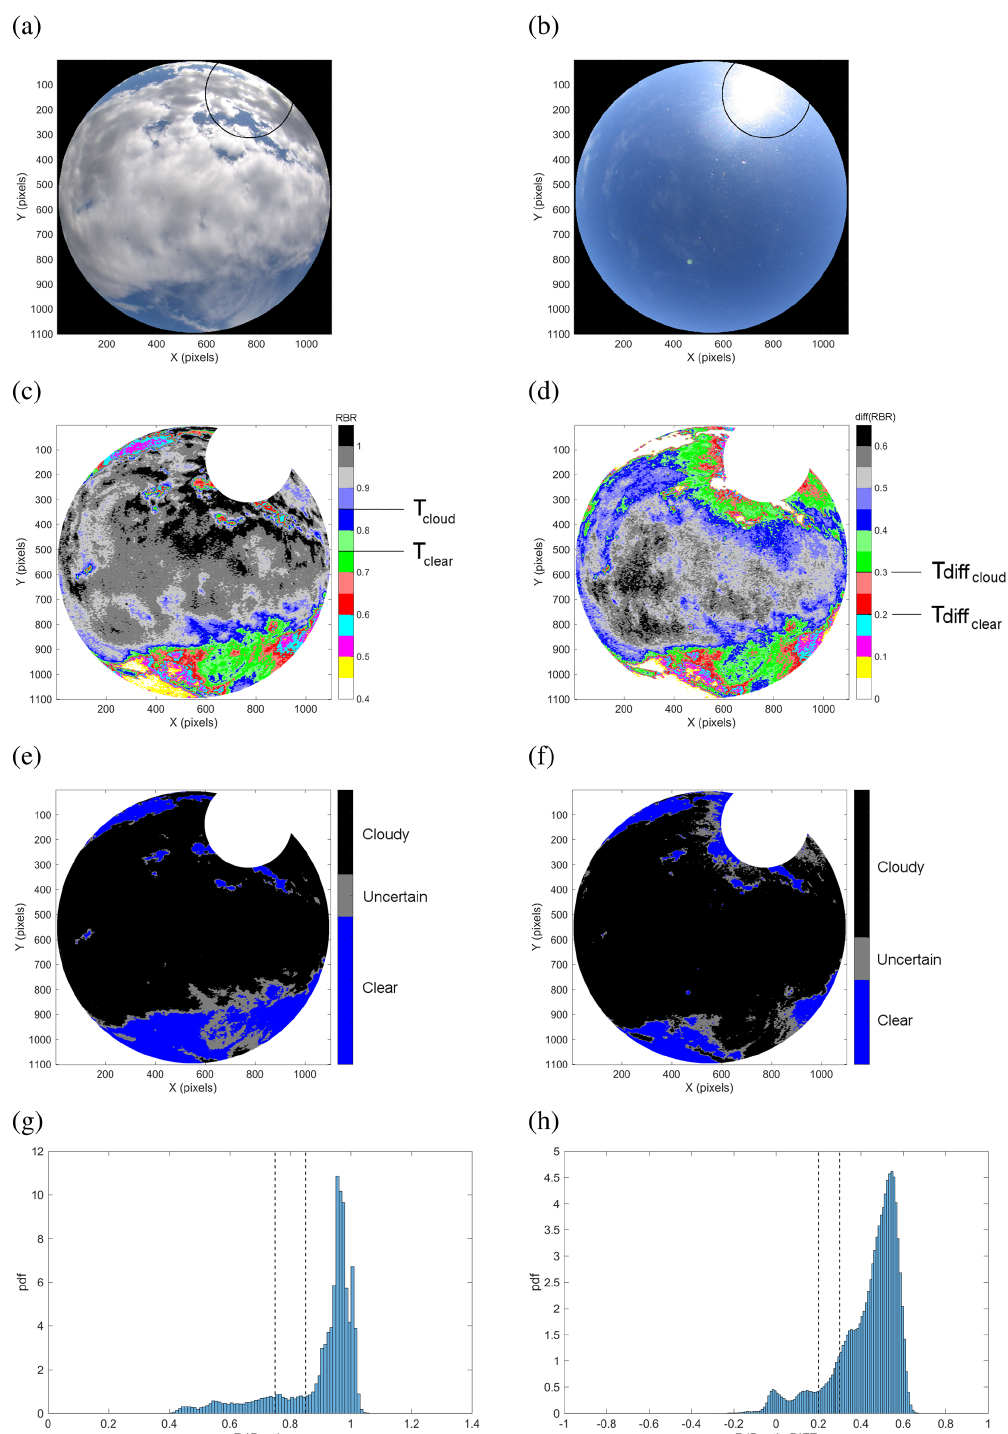
Figure 6. (a) Cropped image of 13 February 2018 at 10:30UTC. (b) Cropped reference image used for the differential process; 12 Febru- ary 2014 at 10:30UTC. (c) RBR of cropped image (a) (for absolute process). (d) RBR difference between image (a) and reference image (b) (for differential process). (e) Result for cloudy, cloud-free, and uncertain pixels from the absolute process. (f) Result for cloudy, cloud- free, and uncertain pixels from the differential process. (g) PDF of the RBR in the initial cropped image (see c ). (h) PDF of the RBR difference between the initial cropped image and the referential cropped image (see d ). In (g) , the black dashed lines correspond to the thresholds T clear = 0 . 75 and T cloud = 0 . 85. In (h) , they correspond to the thresholds T diff clear = 0.2 and T diff cloud = 0 . 3. In (c) , (d) , (e) , and (f) , “clear” means